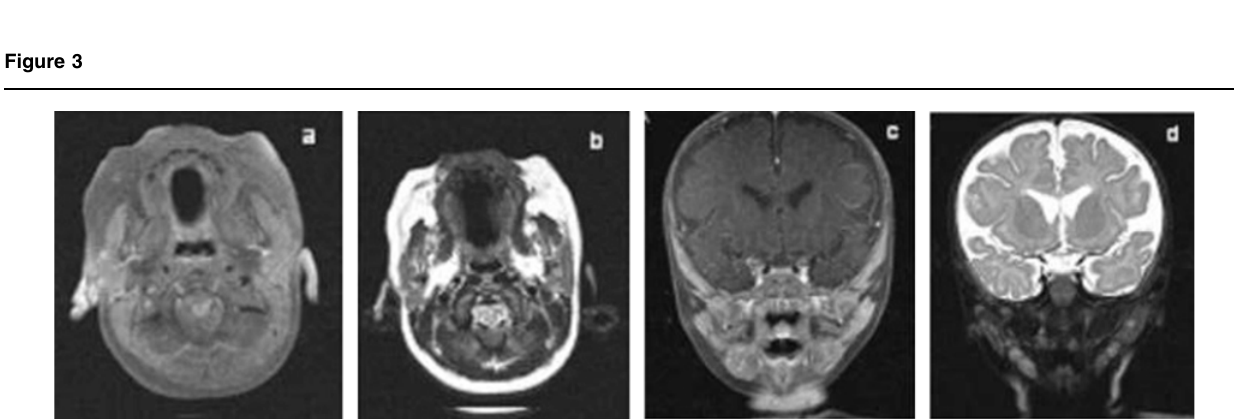
Cervical MRI: slight prominence on the left parotid gland with no structural alterations. (a) T1 axial cut; (b) T2 axial cut; (c) T1 coronal cut; (d) T2 coronal